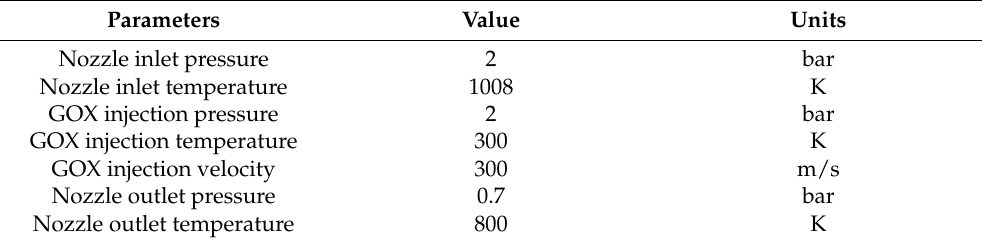
Table 6. Gas generator design properties.